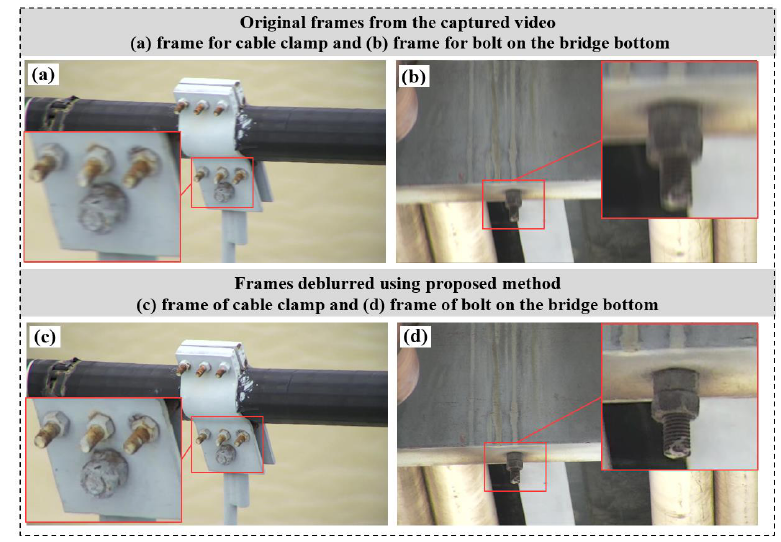
Figure 14. Example of original frames and motion deblurred frames: ( a ) and ( b ) are motion-blurred images captured from the original video obtained by the UAS, and ( c ) and ( d ) are the two captured images processed by the proposed deblurring method.